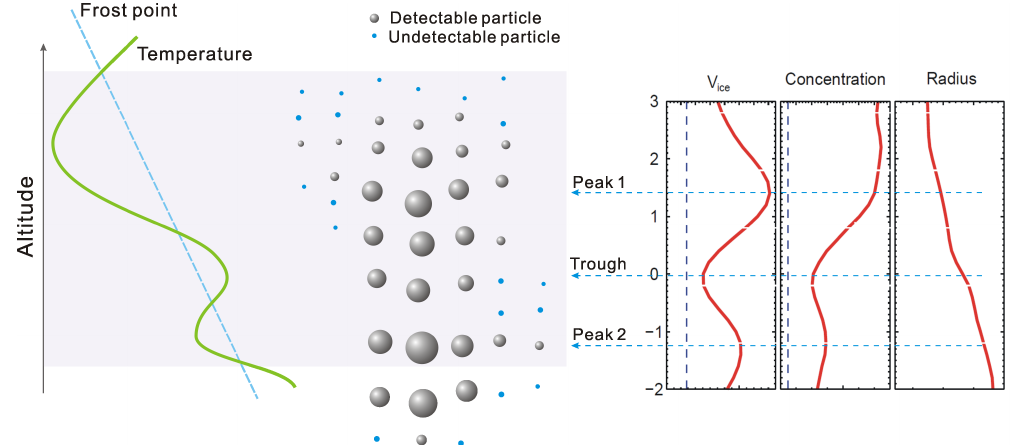
Figure 7. Illustration of the double-layer structure of the PMC particle evolution. Grey solid circles denote particles which are large enough to be detected by SOFIE, while the blue solid circles are undetectable tiny particles. The right panel provides three real mean profiles of double-layer events in the NH derived from Fig.